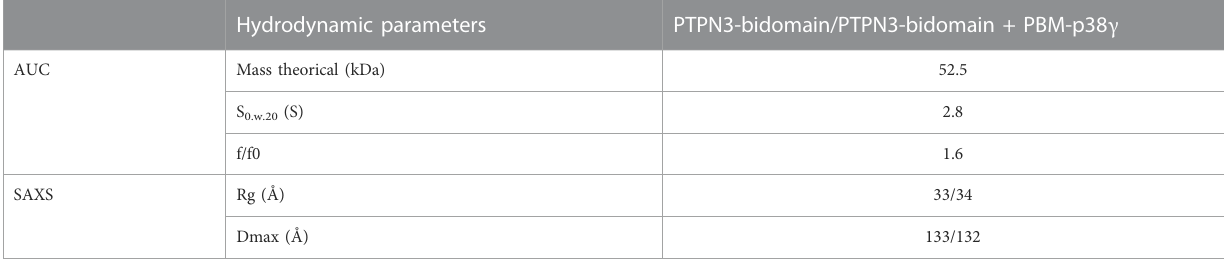
TABLE 4 Hydrodynamic parameters of PTPN3-Bidomain derived from the analysis of AUC and SAXS data. Hydrodynamic